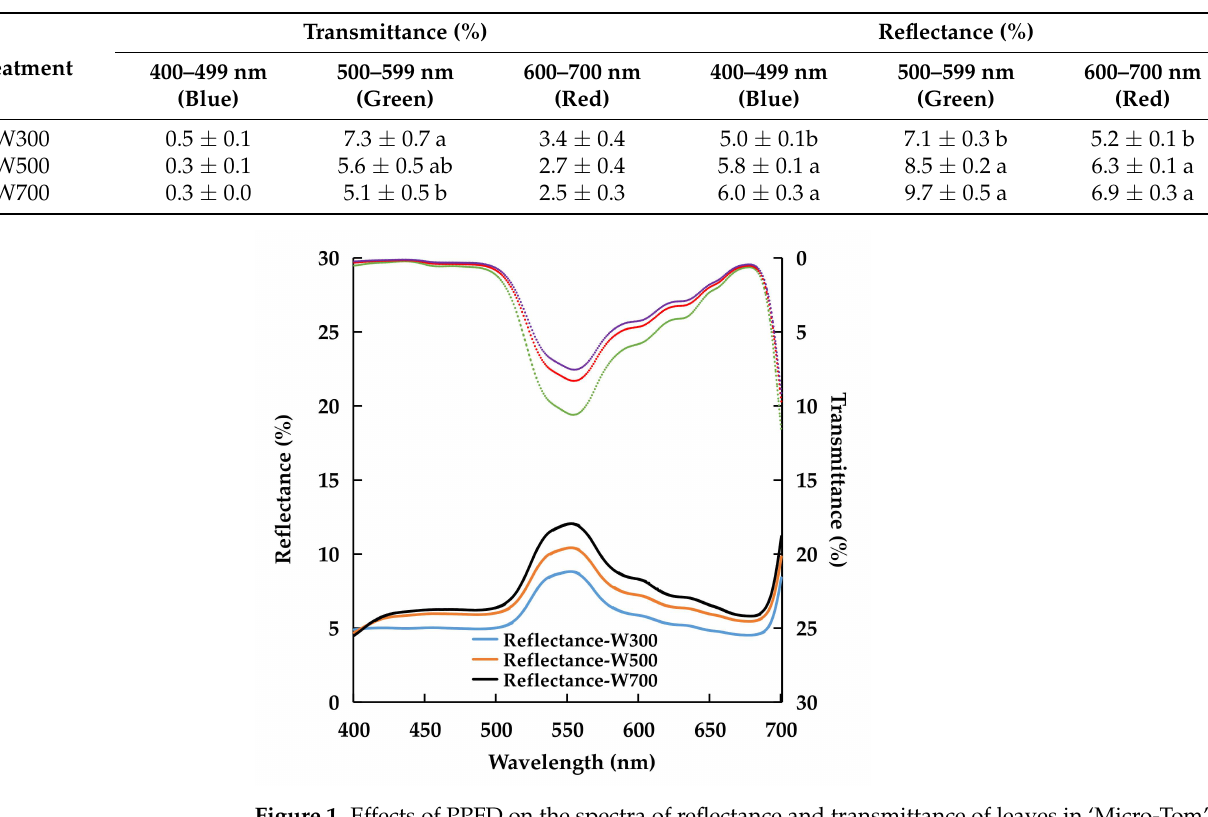
Figure 1. Effects of PPFD on the spectra of reflectance and transmittance of leaves in ‘Micro-Tom’ 10 DAT in Experiment 1. The range of measured light spectrum was 400–700 nm. W300, W500, and W700 denote 300, 500, and 700 µ mol m − 2 s − 1 PPFD, respectively. Each value represents the average of the values of eight plants.